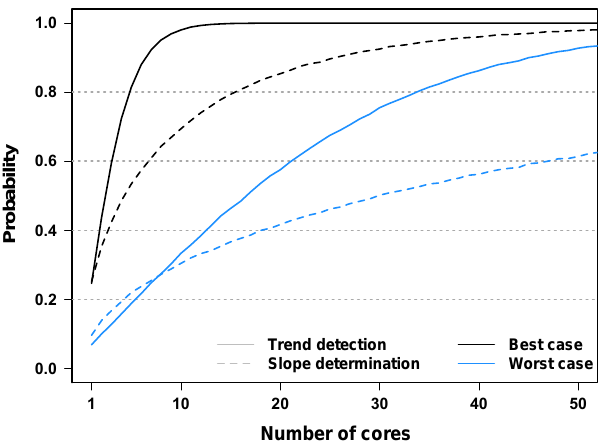
Figure 9. Probability of detecting a linear temperature trend of 0 . 5 ◦ C (50yr) − 1 ( p = 0 . 05) (solid lines) and of determining the strength of the trend with an accuracy of 25% (dashed lines) as a function of the number of firn cores averaged and for the two sce- narios of the annual noise variance discussed in the text (black: best case, blue: worst